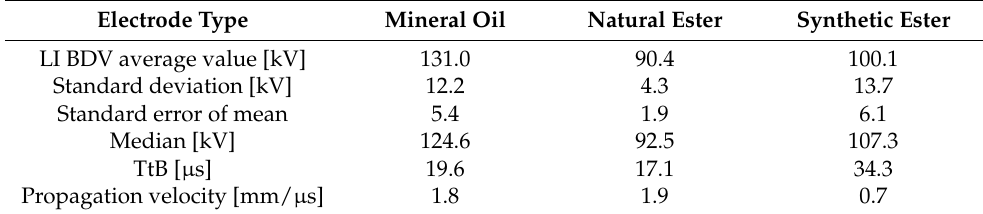
Table 10. Characteristic values describing LI-based